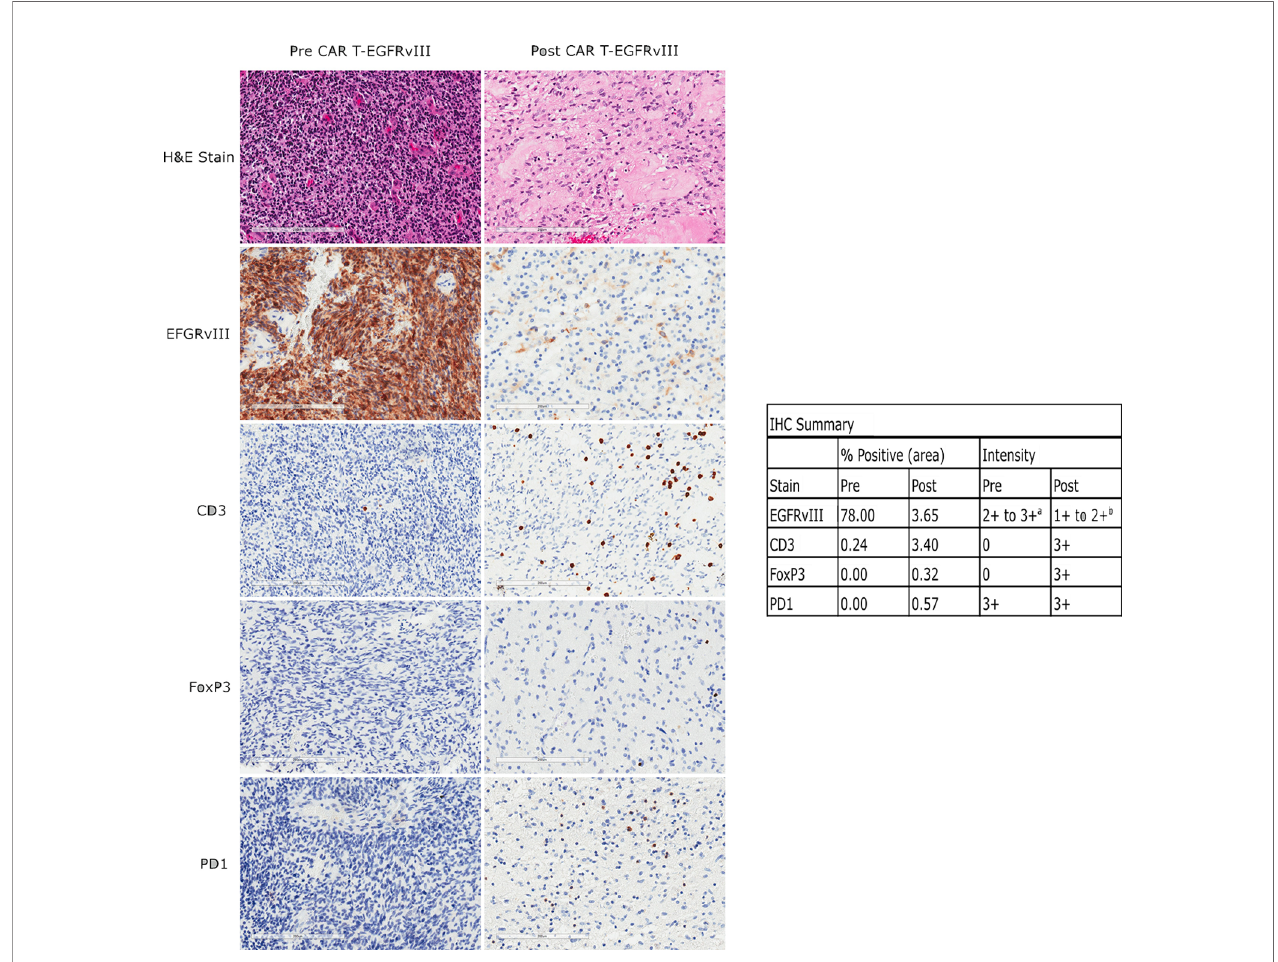
FIGURE 3 | Immunohistochemical (IHC) analysis of EGFRvIII, CD3, FoxP3, and PD1 expression in the patient ’ s tumor before and after CAR T infusion. The left panels show tissue from her original surgery, prior to any treatment. The right panels show tissue from her surgery 104 days after CAR T infusion. Scale bars are 200 µm. Percent positivity by area was calculated by ImageJ as described in the methods, and staining intensity is by pathologist assessment. a: Pre-treatment fi elds also contain scattered 1+ EGFRvIII positive cells of unknown type. b: The positive cells are of undetermined